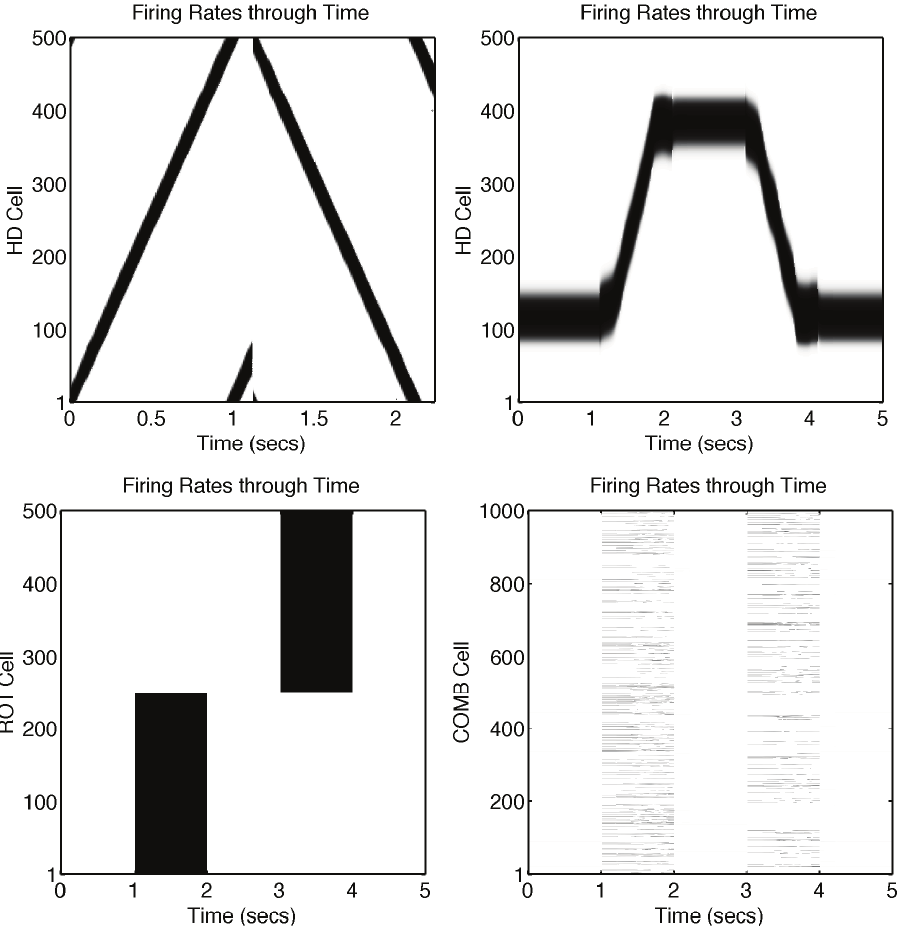
Figure 8. Firing rates of Head Direction (HD), Combination (COMB), and Rotational Velocity (ROT) cells during training and testing. These results are from a simulation with an axonal conduction delay of 100 ms, and a rotational velocity during training of 360 0 = sec (all other parameters are as given in Table 1). Conventions are as for Figure 7.